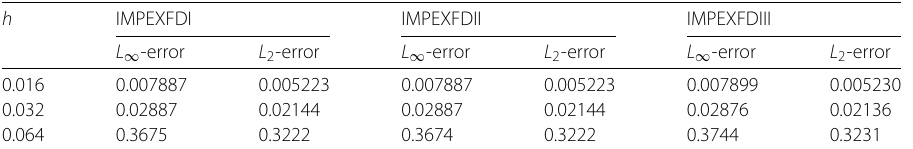
Table 3 The errors of the implicit exact finite difference schemes with (cid:3) t = 10 h h IMPEXFDI IMPEXFDII